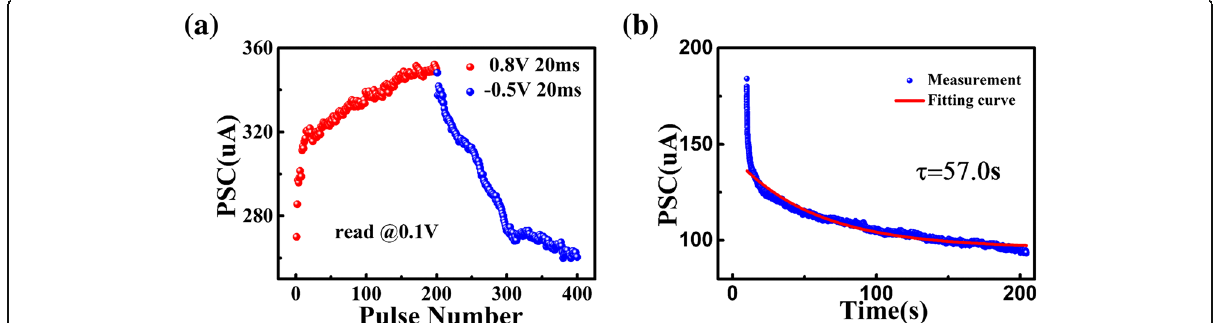
Fig. 2. The means ( μ ) of the set voltage and reset voltage are 0. 99 V and − 1. 33 V, respectively, which showed the average level of operating voltage. The standard deviation ( σ ) of the operating voltage (0.245 for set process and 0.566 for reset process) indicated the degree of deviation from the center. The relative fluctuation of data could be described as a coefficient of variance ( σ / μ ). Superior uniformity was obtained in the set process while the variation of HRS resistance and reset voltage are remarkable, which could attri-